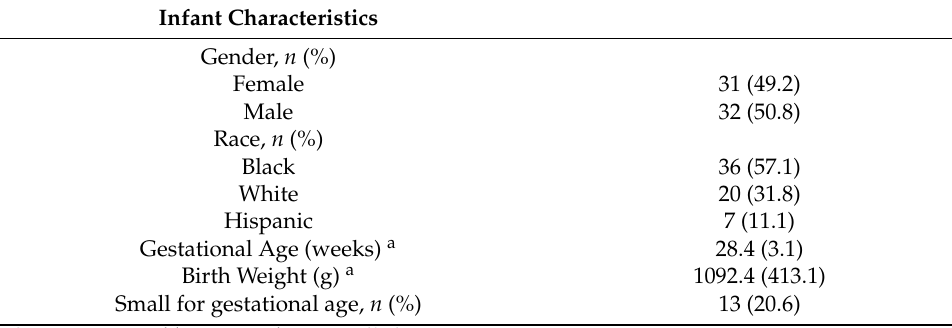
Table 1. Infant characteristics of study population ( n = 63).